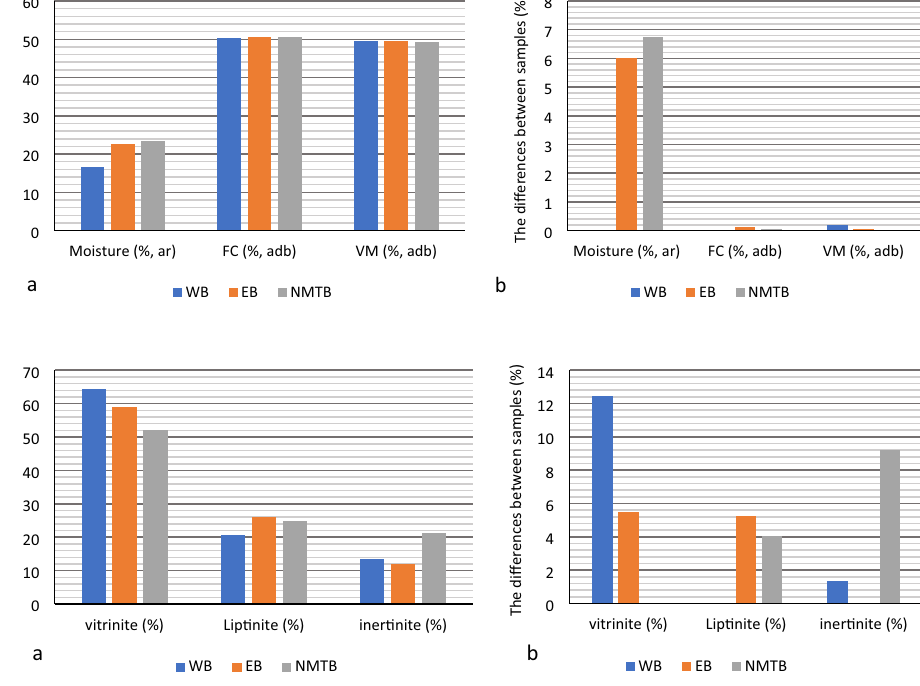
Fig. 6 a The result of proximate analysis and b the differences coal samples with samples contained the lowest value of moisture, fixed carbon and